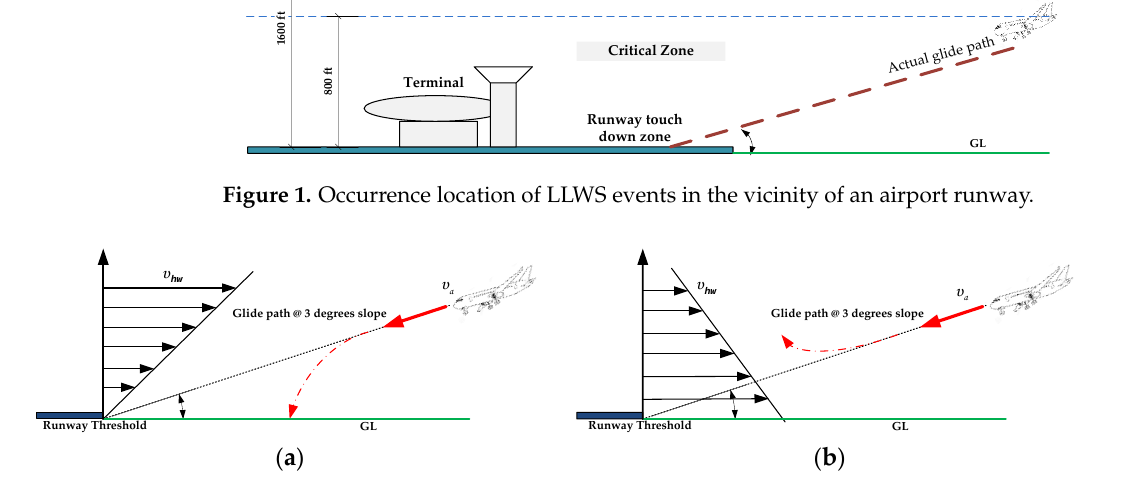
Figure 2. Detrimental and potentially hazardous effects of LLWS on approaching aircraft: ( a ) declining headwind during final approach; ( b ) rising headwind during final approach.